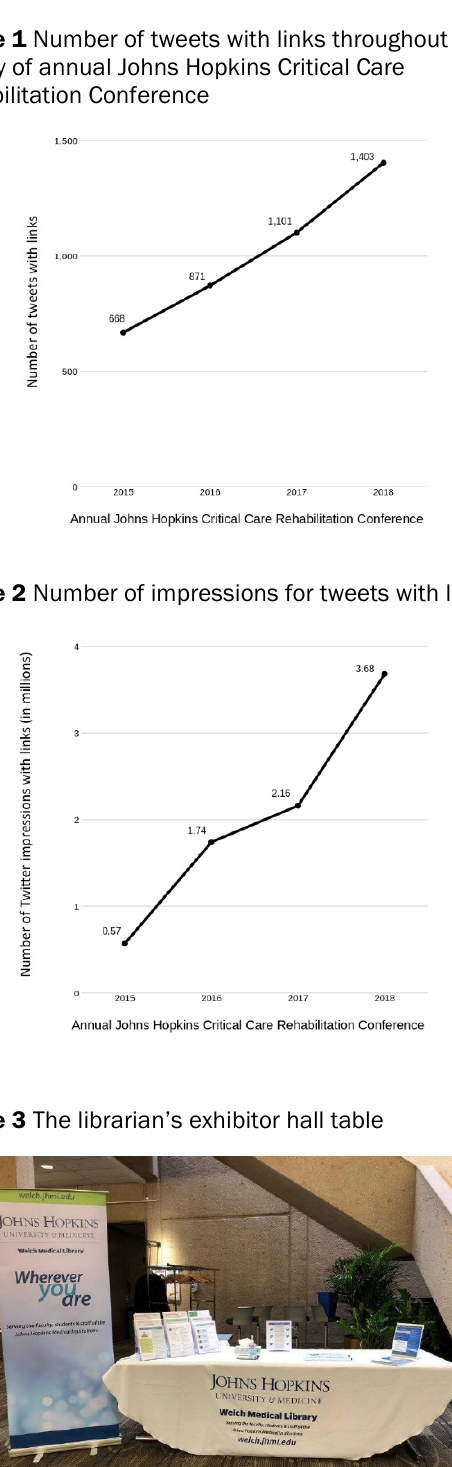
Figure 1 Number of tweets with links throughout